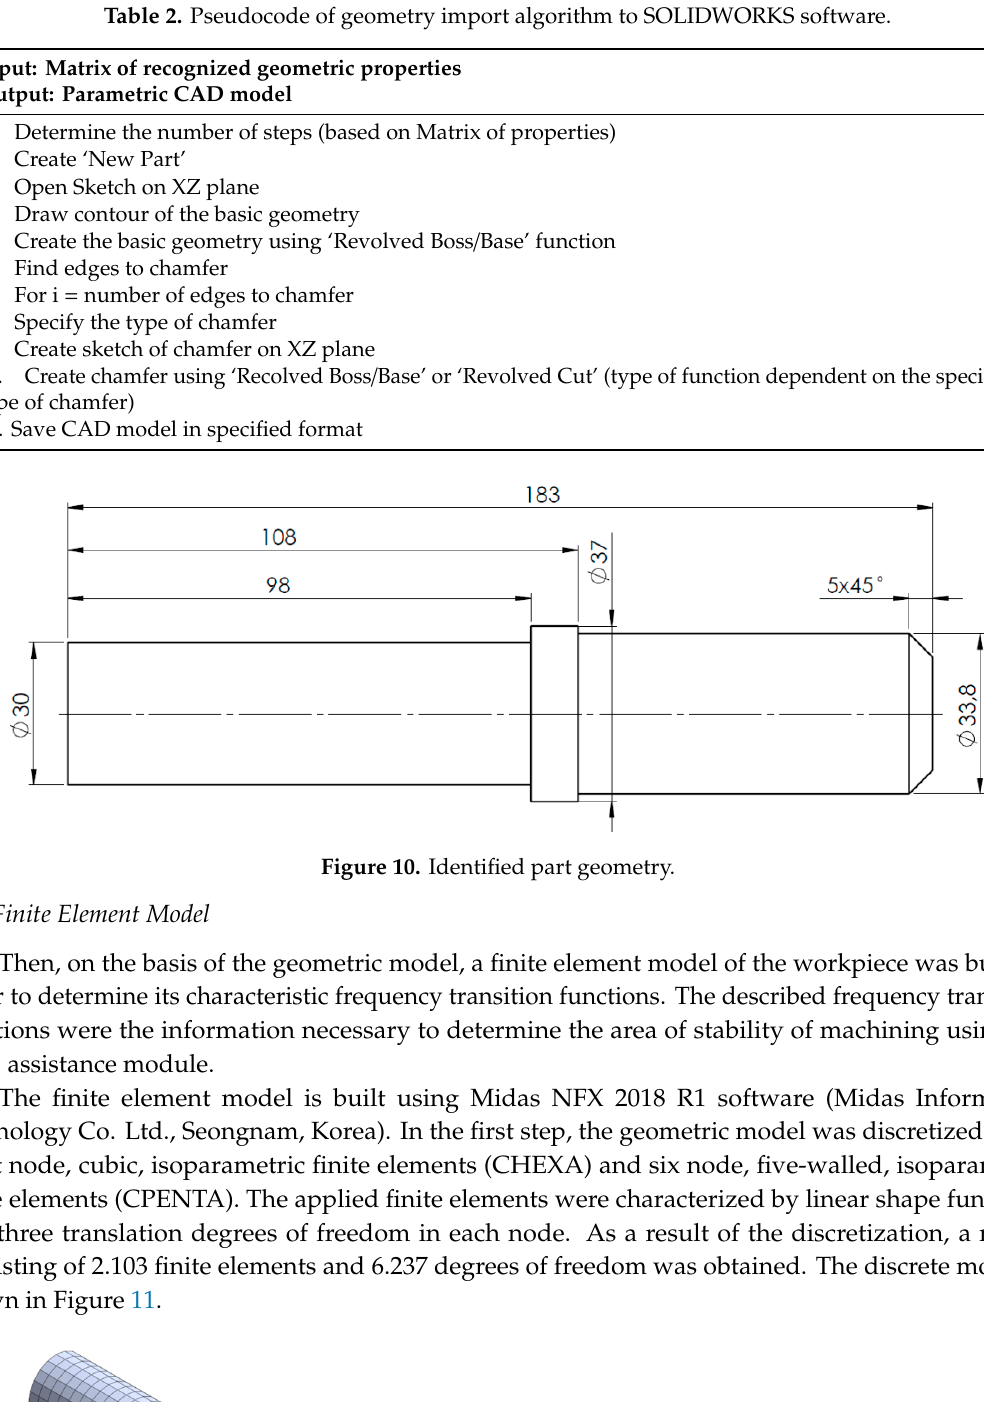
Figure 11. Discretized model of analyzed shaft, ( a ) isometric view and ( b ) cross-sectional view.